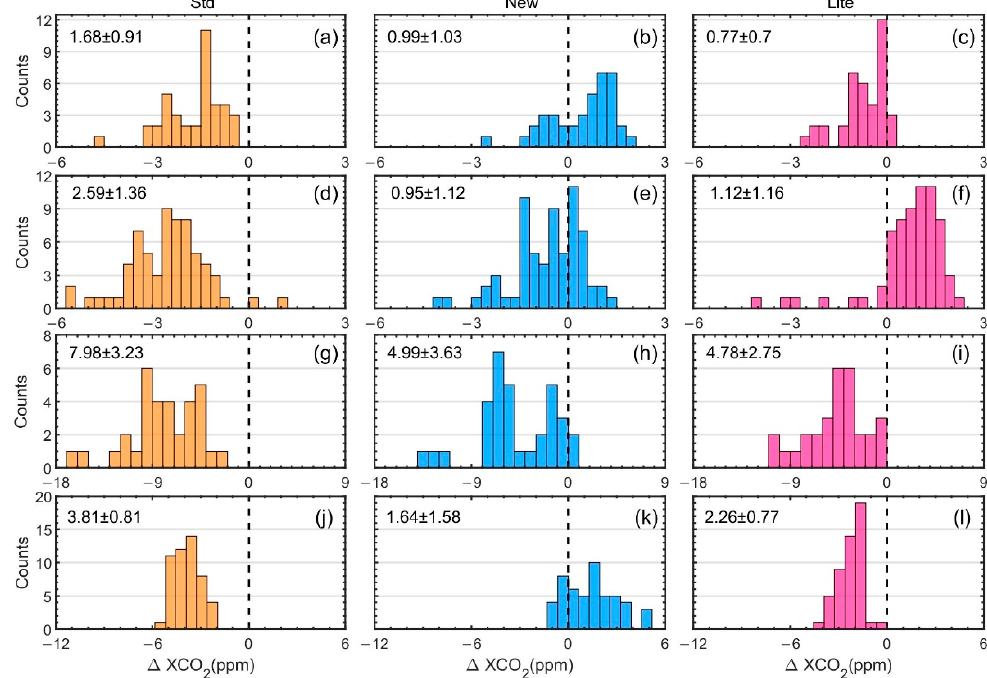
Figure 7. Stacked histogram of XCO 2 measurement difference between the X CO 2, i and X CO 2, TCCON ( i = Std , New, and Lite ). The orange, blue, and pink histograms represent the Standard, new optimiza- tion, and Lite products. Comparison results: ( a – c ) 7 September 2015 at Bremen; ( d – f ) 28 November 2016 at Bremen; ( g – i ) 21 May 2015 at Paris; ( j – l ) 10 September 2015 at Paris.